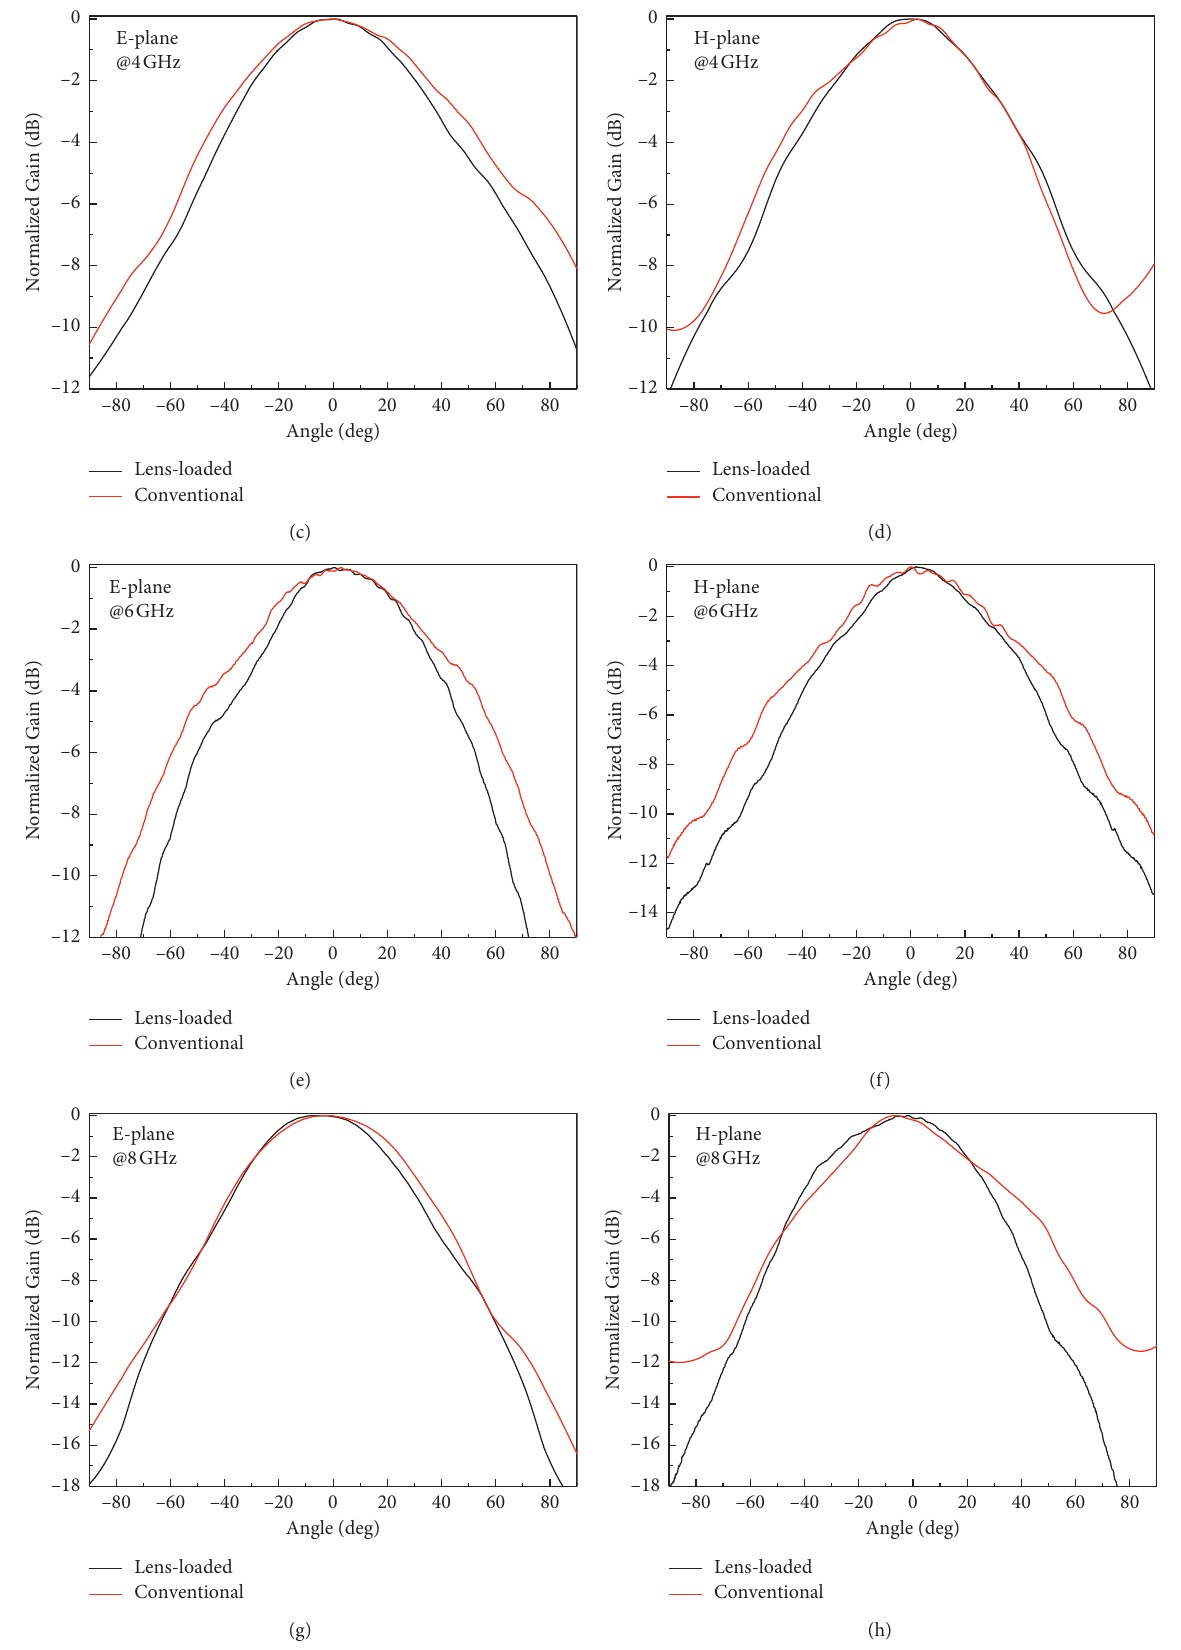
Figure 5: Measured radiation patterns of (a), (c), (e), (g) conventional and (b), (d), (f), (h) lens-loaded FRHAs at